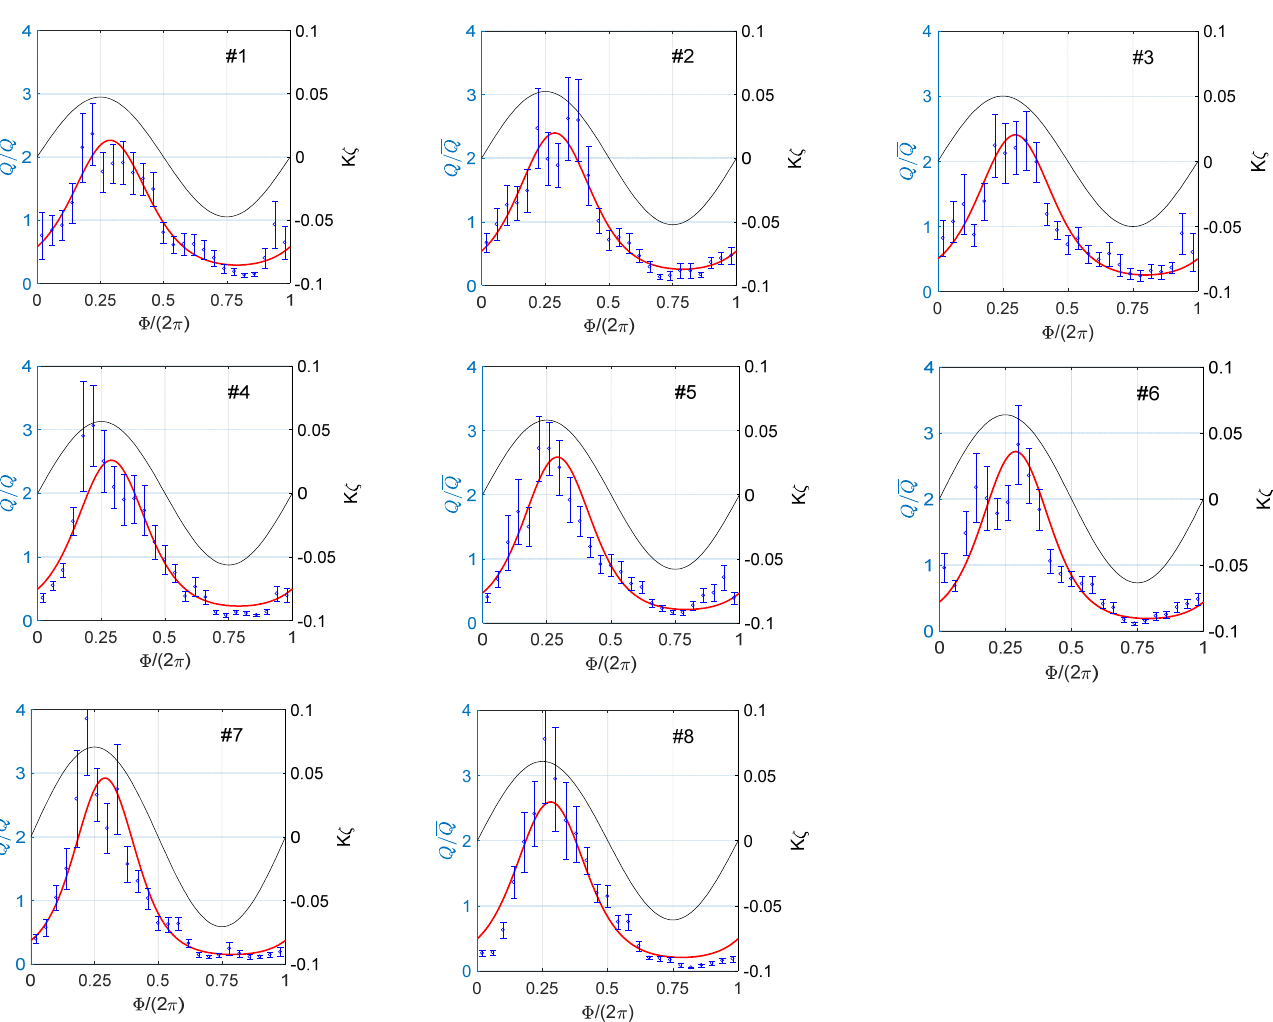
Figure 4. Averaged profiles of normalized whitecap coverage Q / Q (symbols with double-standard-error bars) and dimensionless wave elevations K ζ (black lines) along the wavelength of individual waves for all experimental runs. According to the definition of phase Φ , the wave in Figure 4 runs from the right to the left. Red lines show model calculations for measured characteristics ε , U , α (see Table 1) and model parameters n = 5, 5.0 =ν .